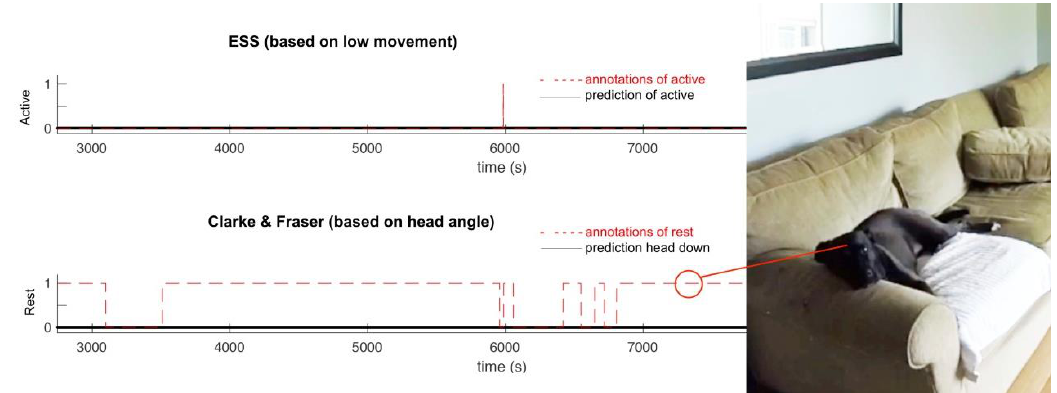
Figure 4. The ESS approach succeeds at predicting Rest (as not active) on low movement detection (prediction matches annotation). Clarke and Fraser’s method fails to predict Rest based on head angle. This case highlights problems predicting Rest based on head angle alone.